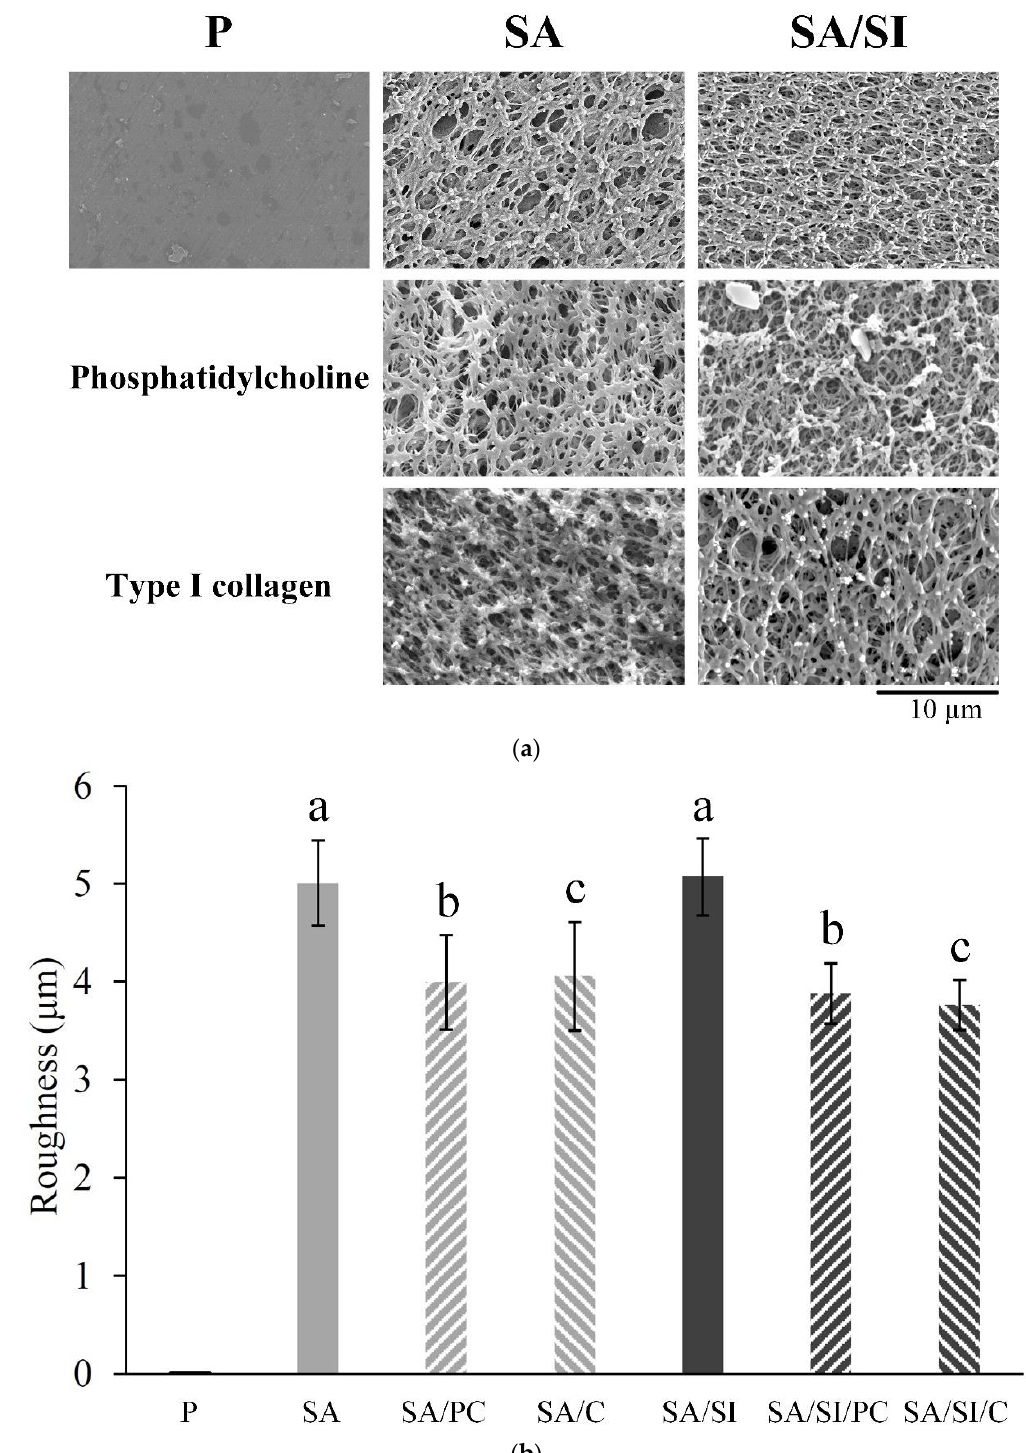
Figure 3. Different surface-modified PEEK measurements of ( a ) microscopic morphological observation and ( b ) roughness tests ( n = 6). Character symbols a, b, and c indicate that each testing group after one-way ANOVA is not significantly different ( p > 0.05).